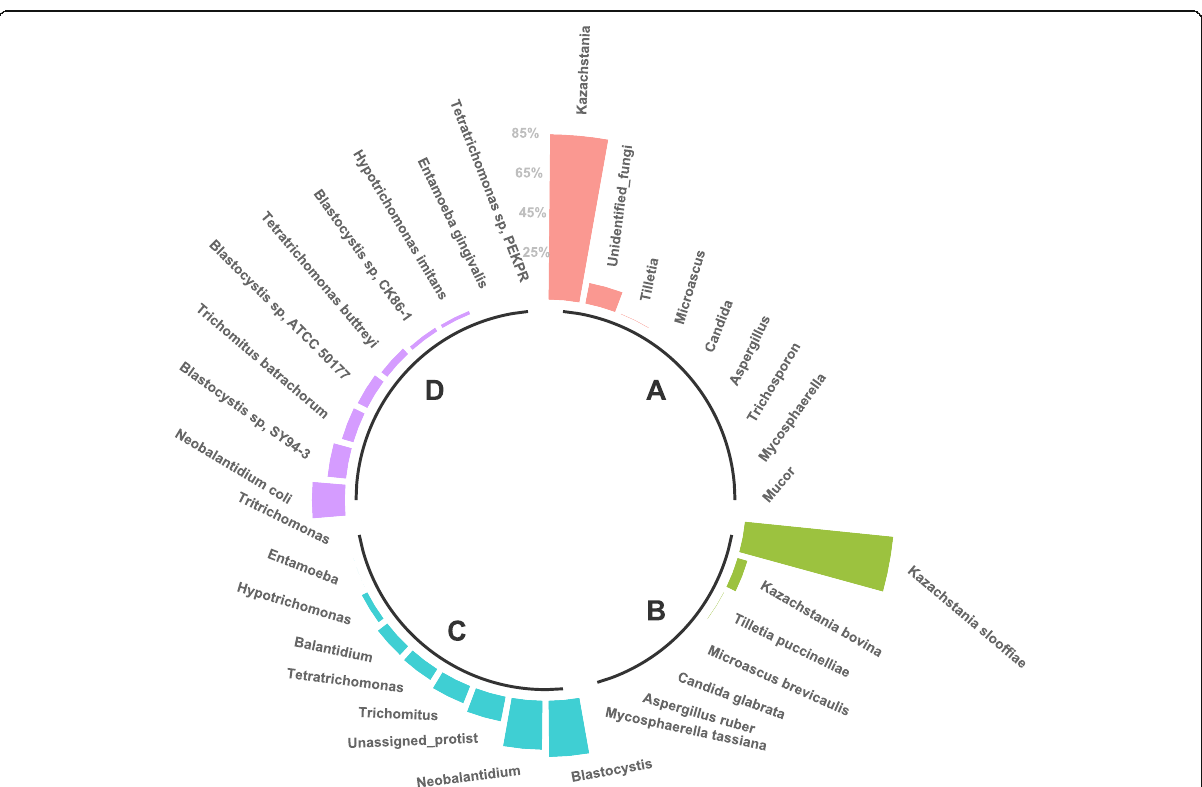
Fig. 1 Circular barplot representing the relative abundance of the most abundant fungal Genus ( a ) and species ( b ) as well as protists Genus ( c ) and species ( d )